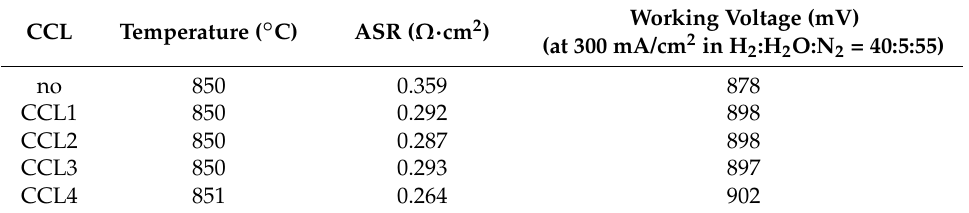
Table 3. ASR of G3 electrolyte supported cells based on thin 3YSZ (electrolyte thickness of 50 µ m)